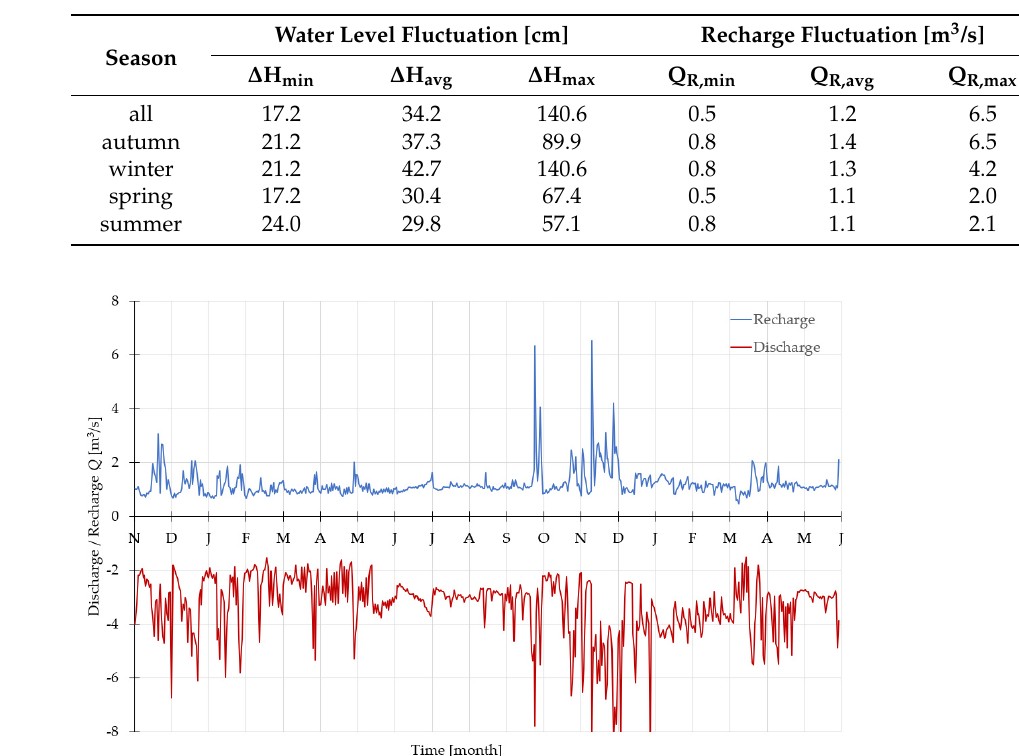
Figure 5. Daily water level regime at PC1 for spring ( a ), autumn ( b ), summer ( c ), and winter ( d ) season—red line represents long − term average for the respective season, and ( e ) long-term average across the seasons. Table 2. Summary of the calculated daily water level fluctuation and corresponding recharge data.